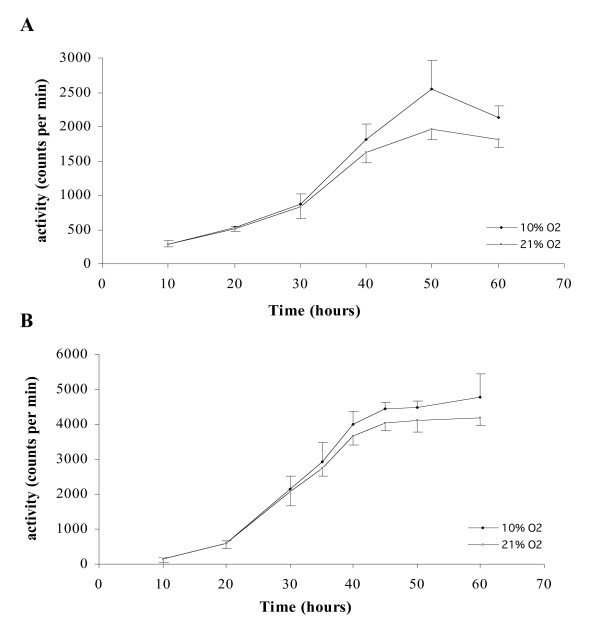
Tritiated hypoxanthine uptake of synchronous Plasmodium falciparum cultures under 10% O2 and 21% O2. Each point represents the mean ± standard deviation of three experiments. A: 3D7 clone. B: W2 clone.